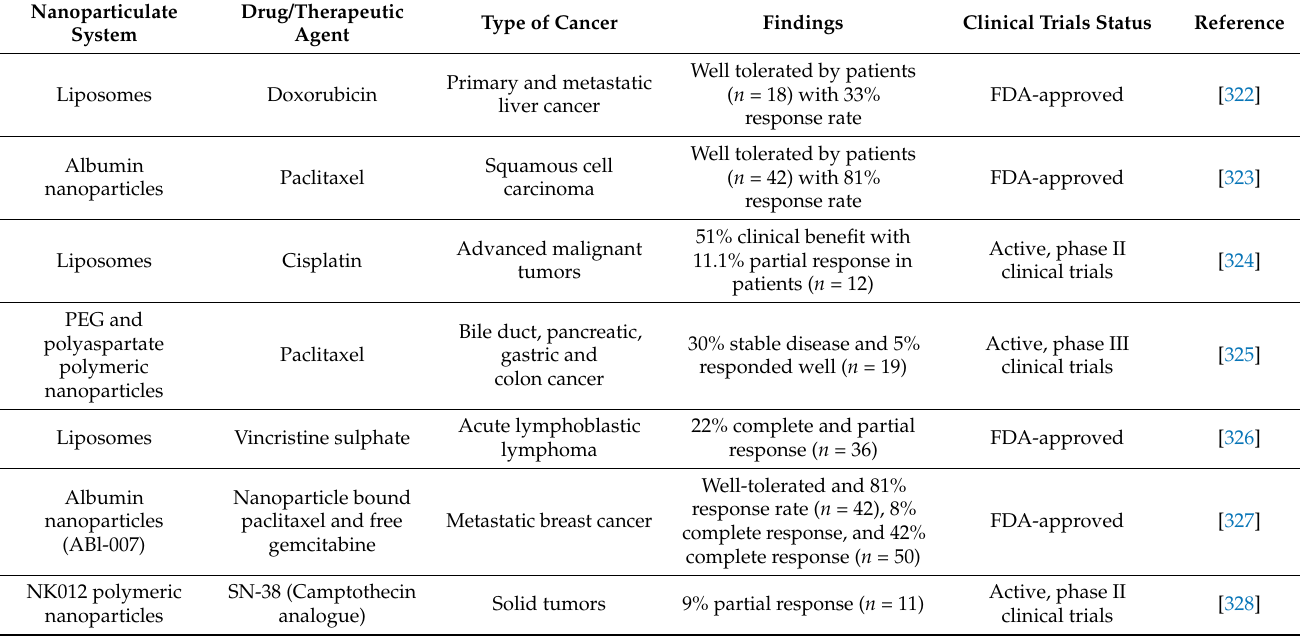
Table 6. An update of nanoparticulate nanomedicine-based anticancer therapeutics clinical trials studies. Nanoparticulate